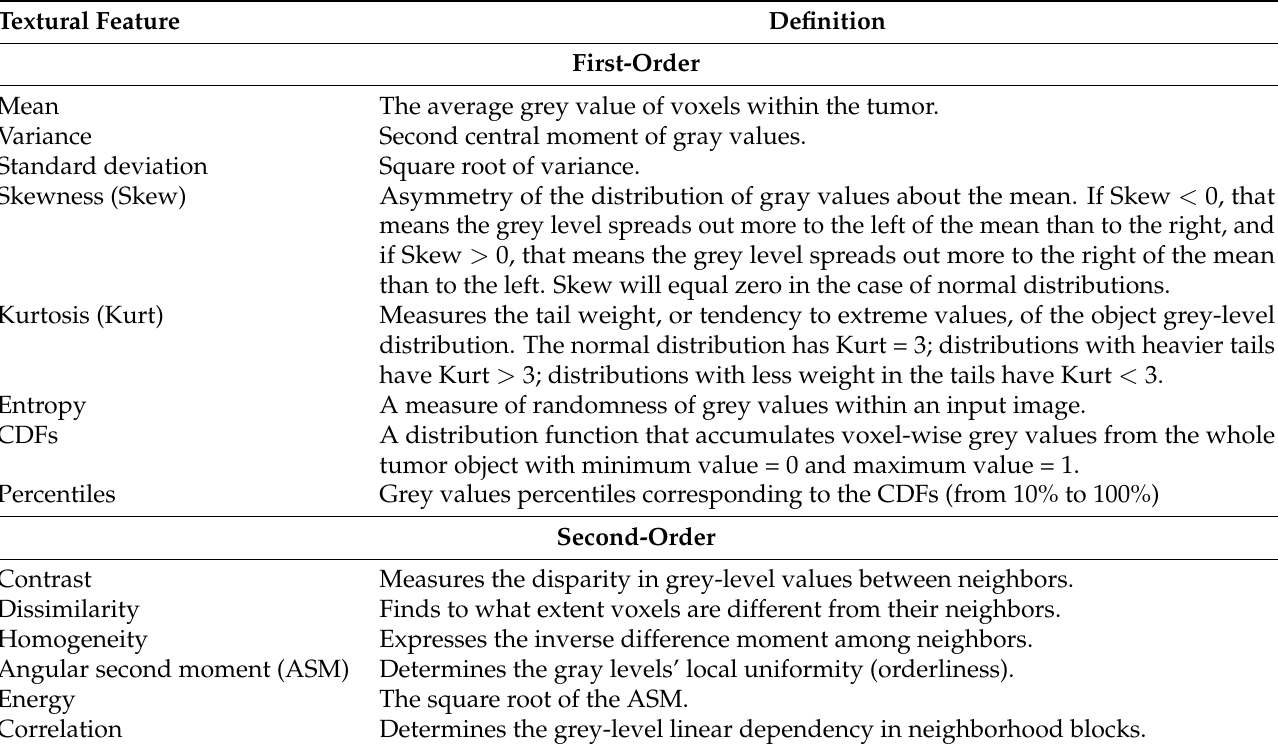
Table 1. Definition of first- and second-order textural features.